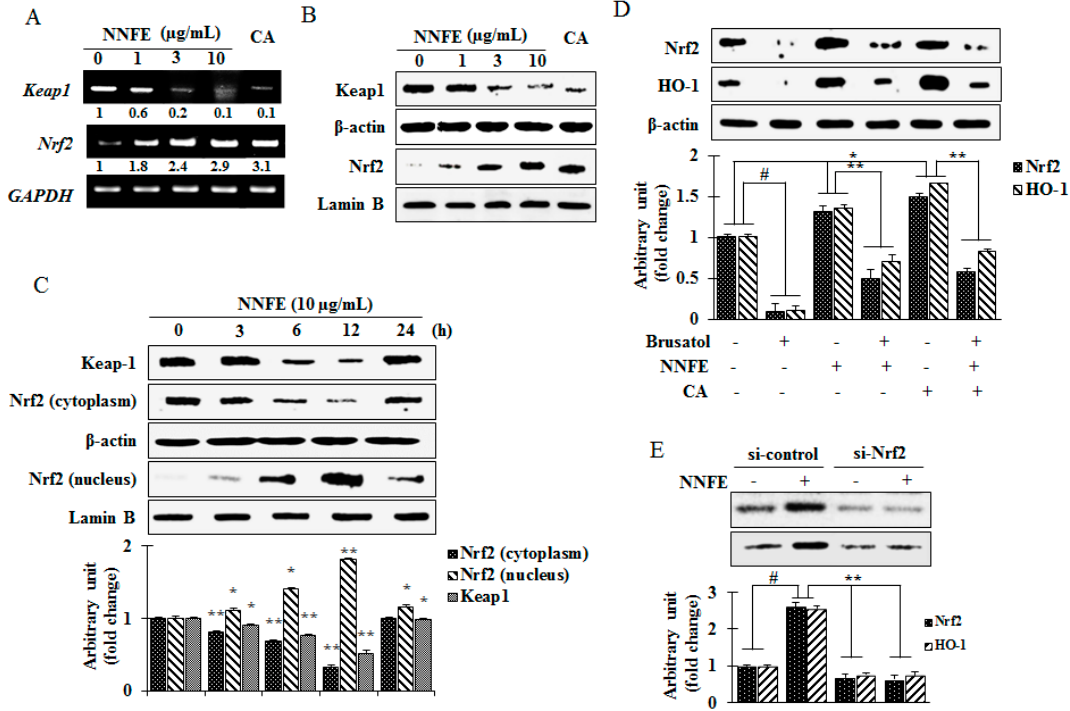
Figure 5. Effect of NNFE on nuclear translocation of nuclear factor erythroid 2-related factor 2 (Nrf2)-mediated HO-1 expression. RAW 264.7 cells were pretreated for 24 h with NNFE. The mRNA expression ( A ) and protein expression ( B ) of Nrf2 and Kelch-like ECH-associated protein 1 (Keap1) were measured by RT-PCR and western blot, respectively. ( C ) The time-dependent effect on the protein levels of cytosolic and nuclear Nrf2 was analyzed by western blot. ( D ) Cells were treated with an Nrf2 inhibitor (brusatol) with and without NNFE, and Nrf2 and HO-1 protein levels were analyzed by western blot. ( E ) Cells were treated with a siRNA of Nrf2 (si-Nrf2) with and without NNFE, and Nrf2 and HO-1 protein levels were analyzed by western blot. Statistical values are expressed as the mean ± SD ( n = 3). # p < 0.001, and * p < 0.05 compared to no treatment, ** p < 0.01 compared to brusatol